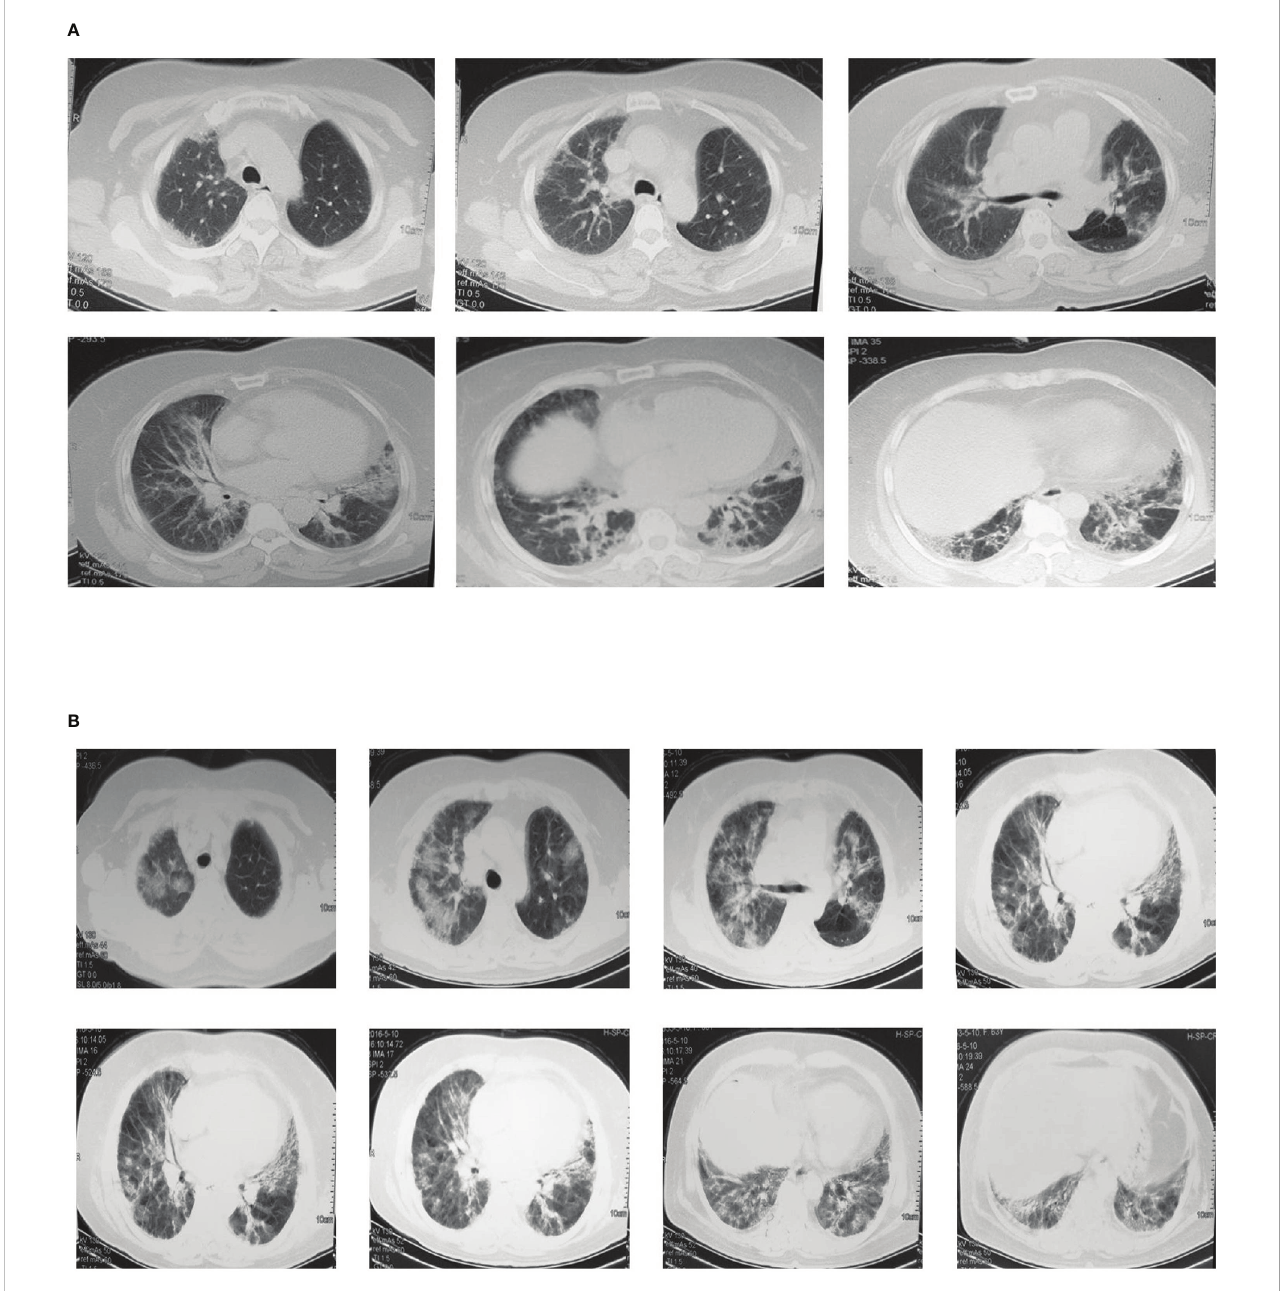
FIGURE 2 Chest CT images of the proband. (A) Multiple ground-glass and grid shadows distributing around the lungs and under the pleura were found in both lungs In December 2015. (B) Multiple patchy shadows, grid shadows and cable shadows were diffusely distributed in both lungs, and some of the shadows fused into large areas in May